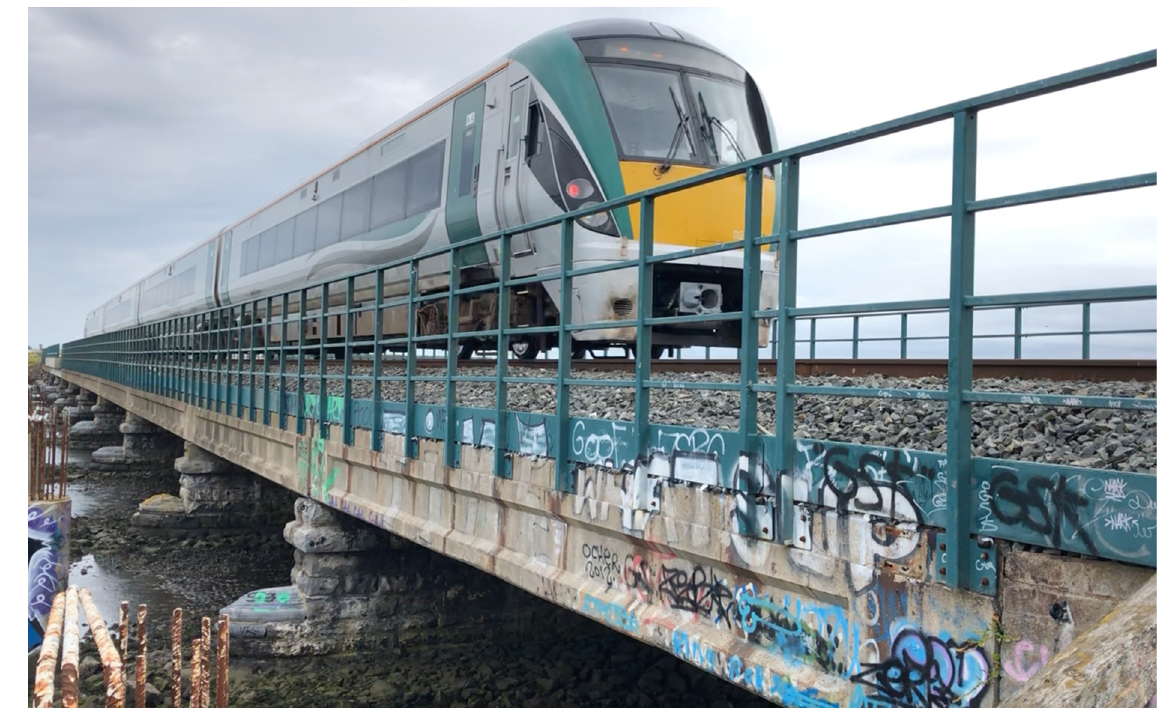
Figure 2. The full view of the bridge with a passing train.